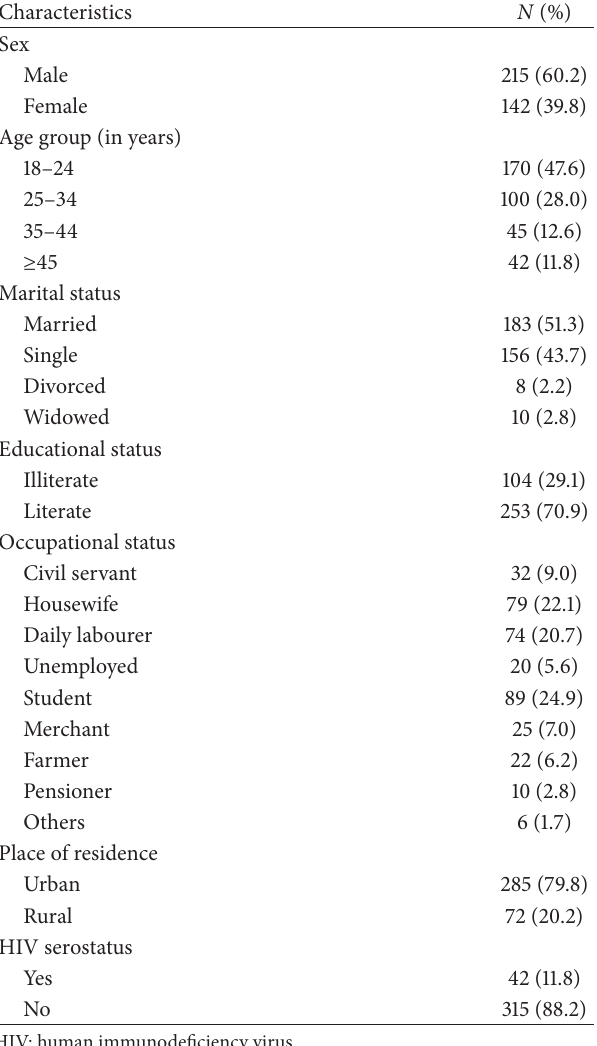
Table 1: Sociodemographic characteristics and HIV status of study participants in Eastern Ethiopia, 2013 ( 𝑛 = 357 ).